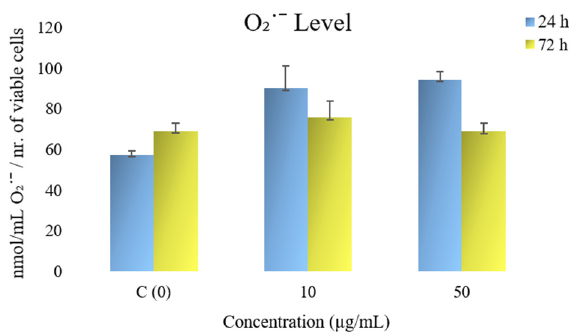
Figure 1. Effects of the LSE treatment on superoxide anion radicals in HeLa cells. Results are presented as means ± standard error.